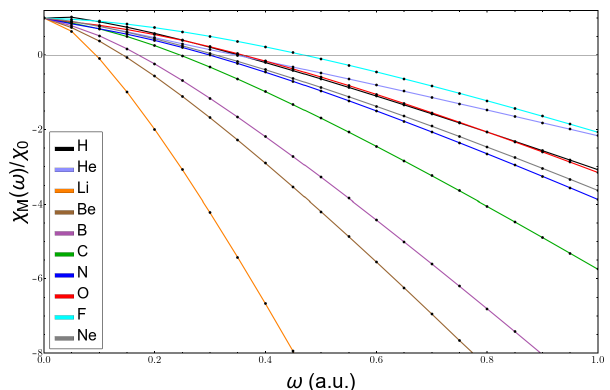
Figure 5. Variation with confinement of the ratio between Mulliken’s electronegativity as a function of ω and its free atom